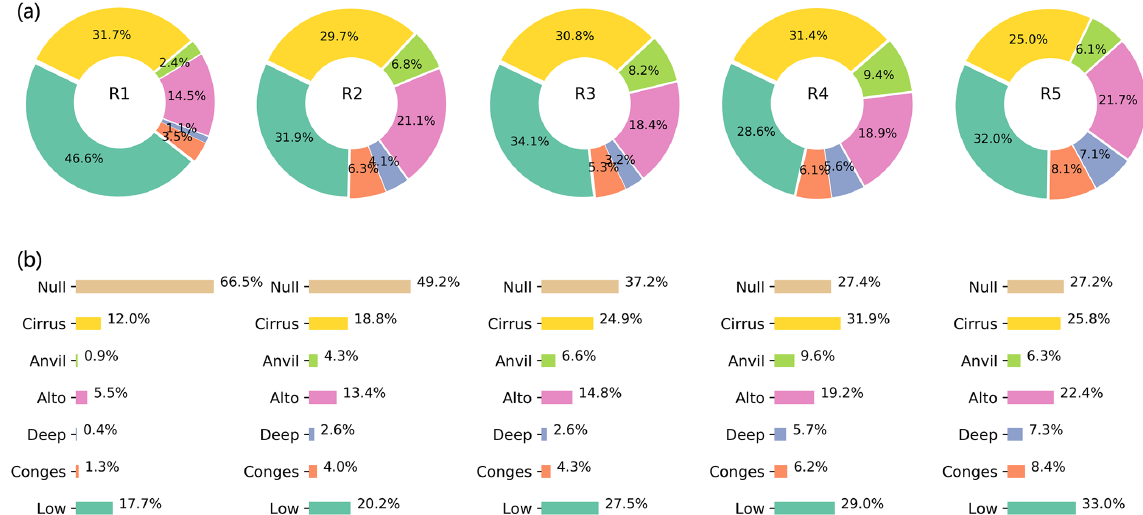
Figure 10. (a) Relative frequency of occurrence for specific cloud types in the column above the MAO site for regime periods between 12:00 and 00:00UTC and (b) percentages when compared to cloud-free